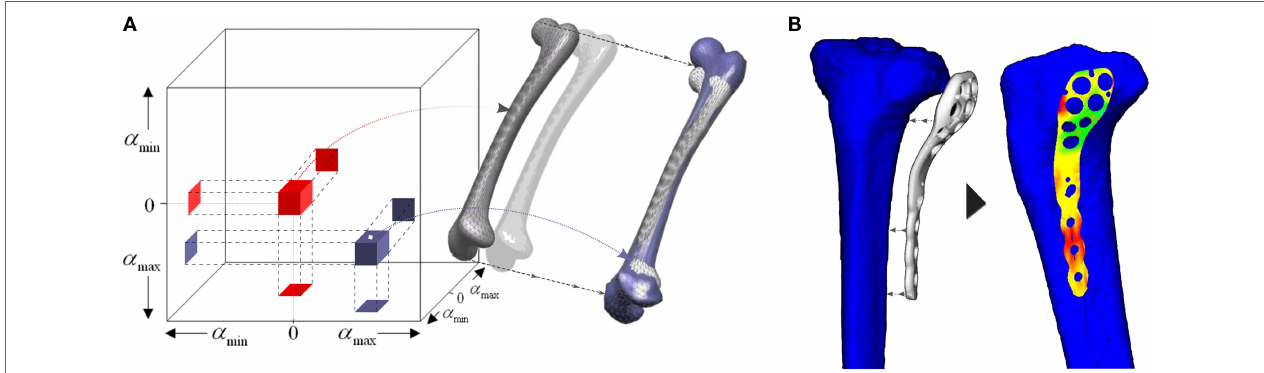
FIGURE 3 | (A) Shape space defined by the PCA of a population of human femur. (B) Implant-fitting method applied for tibial orthopedic implants. Adapted from Kozic et al. (2010).